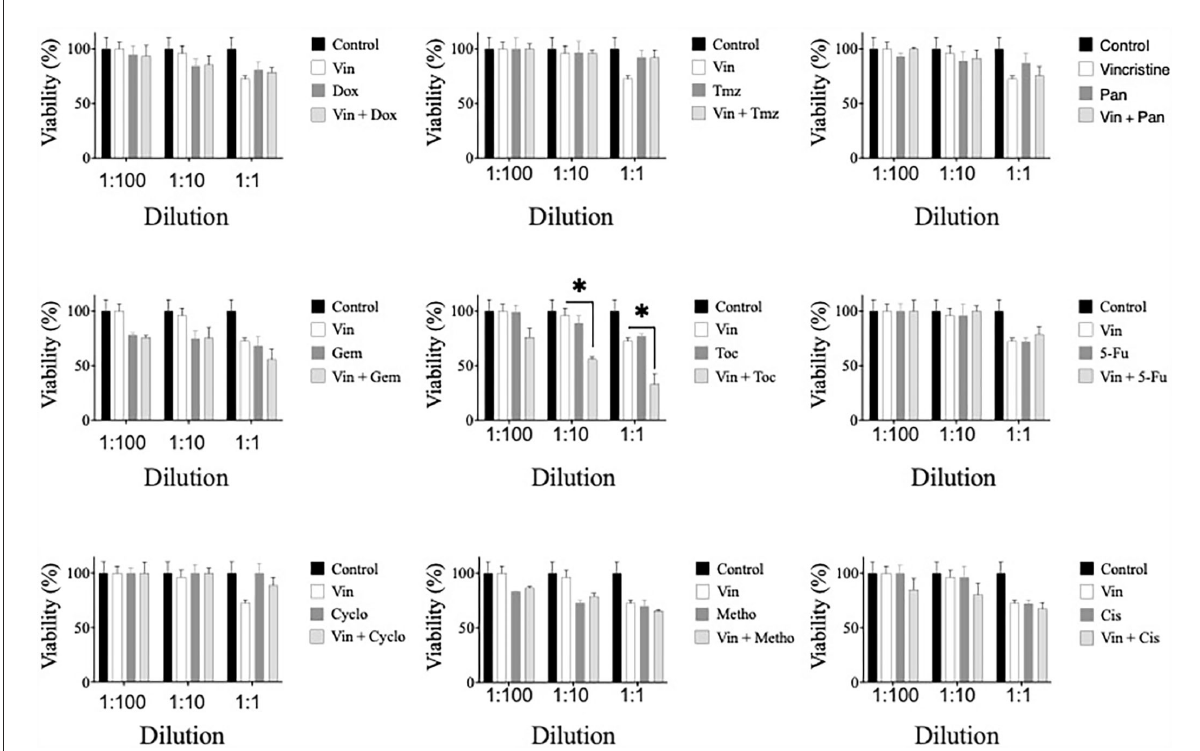
FIGURE3 Viability of CTVT cells exposed to the simultaneous administration of vincristine plus different drugs. TVT cells (5x10 3 /well) were exposed to the CC 50 of Vin plus several dilutions (1:100, 1:10, and 1:1) of the CC 50 of the drugs Dox, Tmz, Pan, Gem, Toc, 5-Fu, Cyclo, Metho, or Cis for 24h. The relative cell viability was determined with the Alamar Blue assay. Each bar graph represents the average of 3 independent experiments ± SD. Statistical significance was determined using Tukey’s post hoc test (* p < 0.05). Vin: vincristine, Dox: doxorubicin, Tmz: temozolomide, Pan: panobinostat, Gem: gemcitabine, Toc, toceranib; 5-Fu, 5-fluorouracil; Cyclo, cyclophosphamide; Metho, methotrexate; Cis,